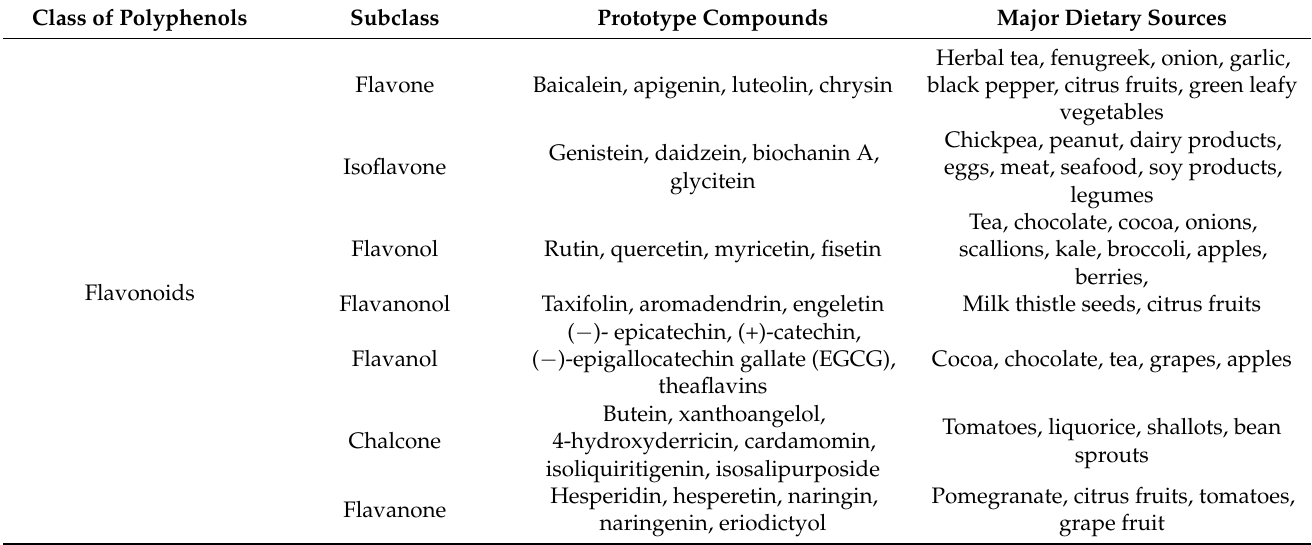
Table 1. Classification of polyphenolic compounds and their main dietary sources with examples